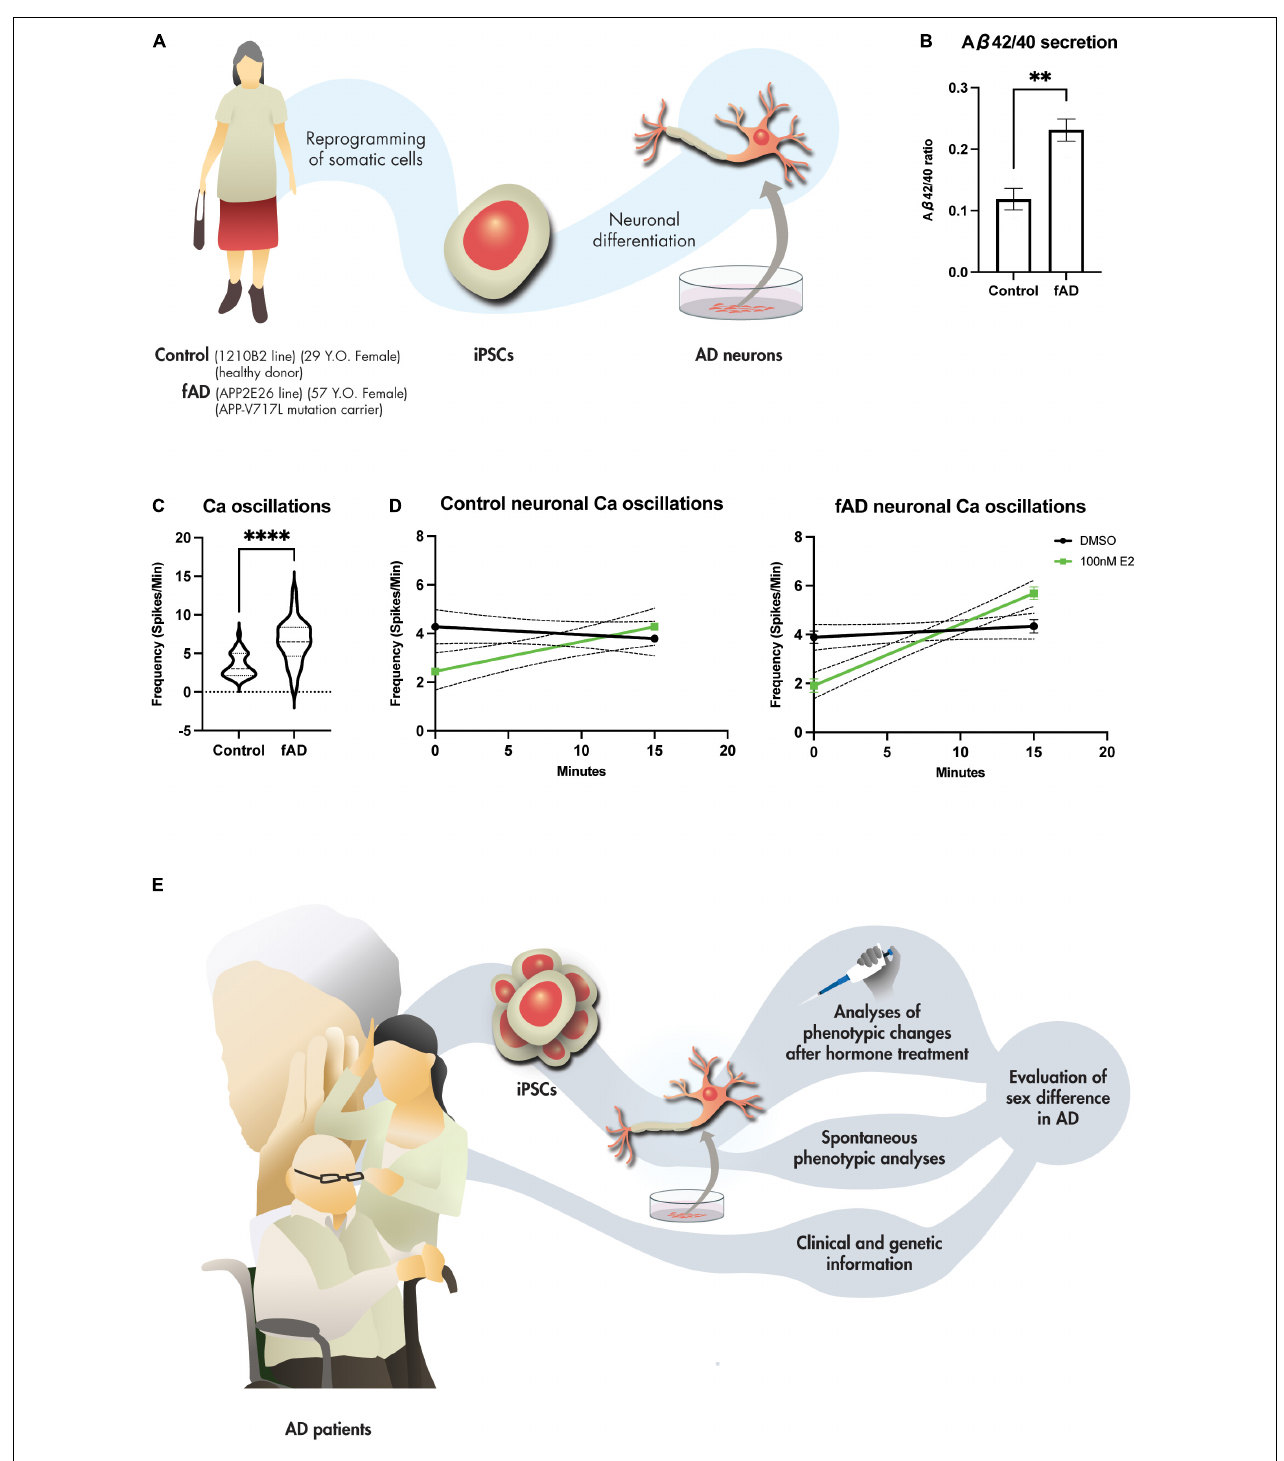
FIGURE 1 | iPSC-derived neurons for the future study of sex difference in AD. (A) Generation of iPSC-derived neurons from female healthy (1210B2 line) and fAD (APP2E26 line) donors. (B) A β 42 / 40 ratio of the iPSC-derived neurons of healthy ( n = 4) and fAD ( n = 4) donors measured at 45 div. Bars, mean ± SEM. ** p < 0.01 (unpaired t -test). (C) Neuronal hyperactivation seen in fAD-derived neurons measured by Ca imaging using Fluo-8 indicator after 45 div ( n = 32 versus 32). **** p < 0.001 (Mann Whitney test). (D) 17 β -estradiol (E2) responses of iPSC-derived neurons measured by Ca imaging using Fluo-8 indicator at 45 div of 1210B2 line and APP2E26 line before (0 min) and after (15 min) treatment with 100 nM E2 ( n = 45 versus 45). p = 0.3331 (1210B2, DMSO); p = 0.0010 (1210B2, 100 nM E2); p = 0.2289 (APP2E26, DMSO); p < 0.0001 (APP2E26, 100 nM E2) (simple linear regression). (E) Stratification and investigation of the hormone therapy effects in AD utilizing iPSC-derived neuronal